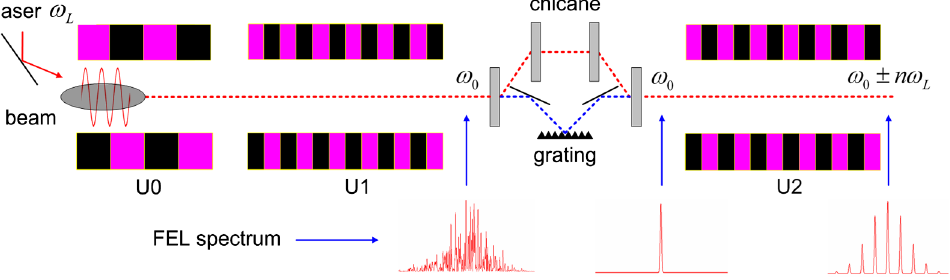
FIG. 1. Schematic for generation of mode-locked multichromatic x rays in a seeded